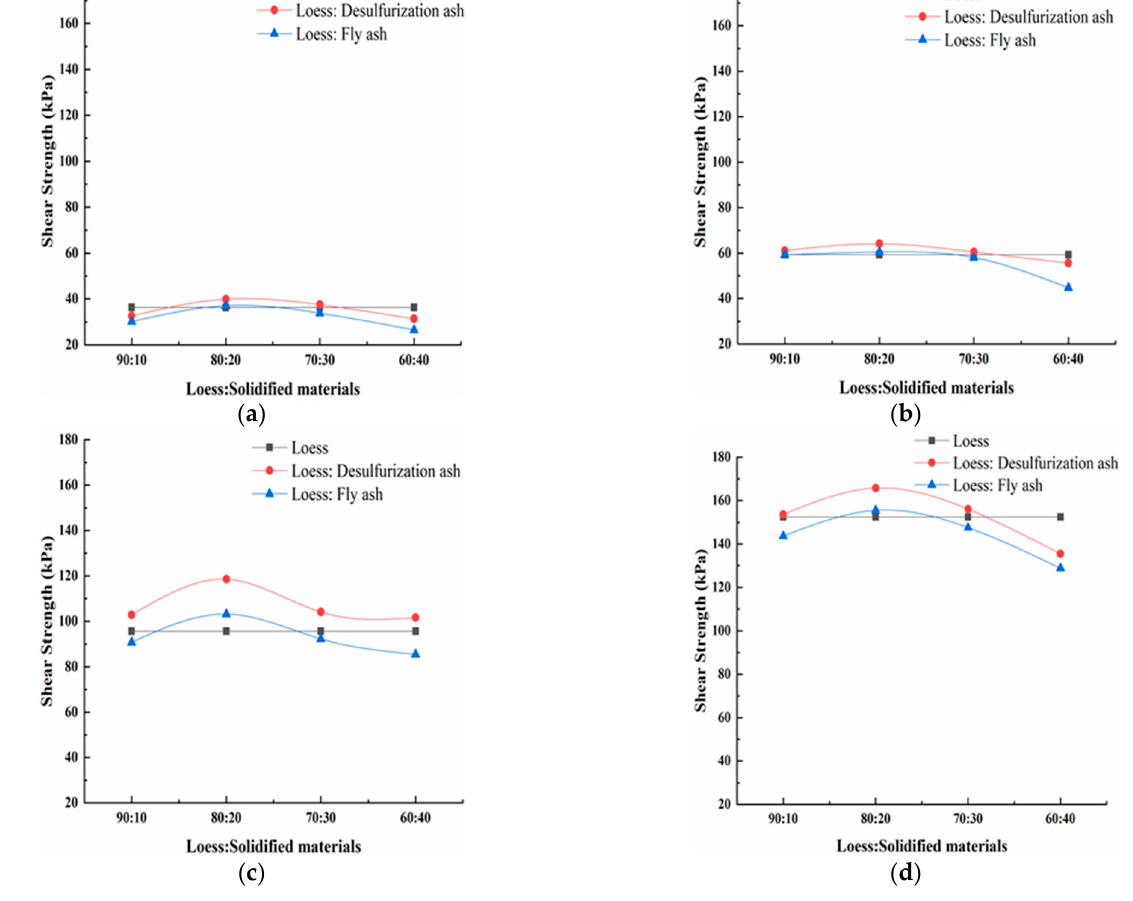
Figure 7. The shear strength of the modified loess under different normal stresses. ( a ) 50 kPa; ( b ) 100 kPa; ( c ) 200 kPa; and ( d ) 300 kPa.